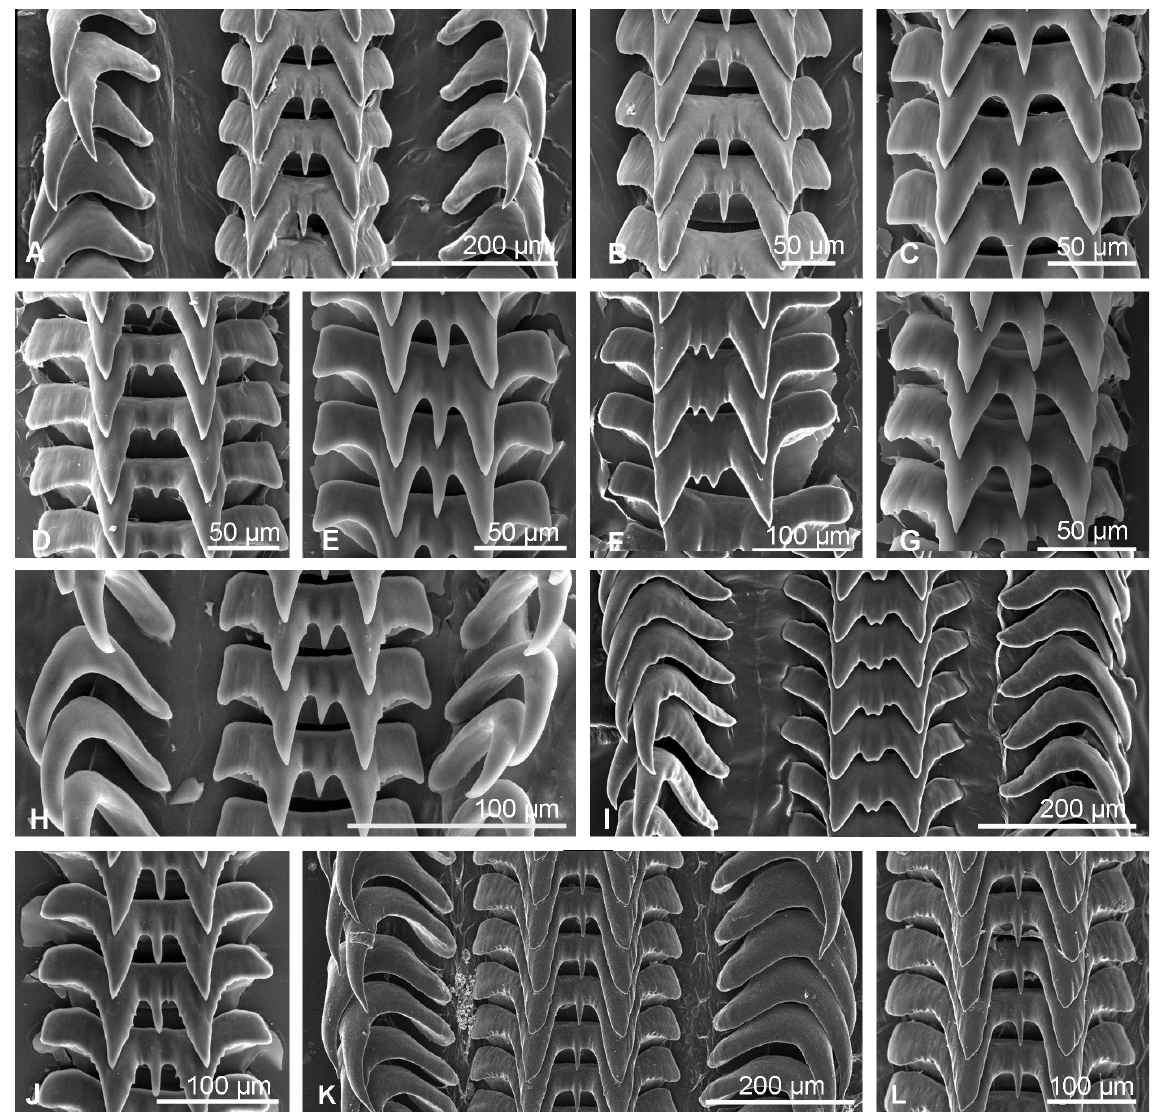
Fig. 7. Radulae of species of Amalda H. Adams & A. Adams, 1853. A–G . A. hilgendorfi (von Martens, 1897). A–B . MNHN IM-2019-621 (shell on Fig. 4D). C . MNHN IM-2009-11961 (shell on Fig.